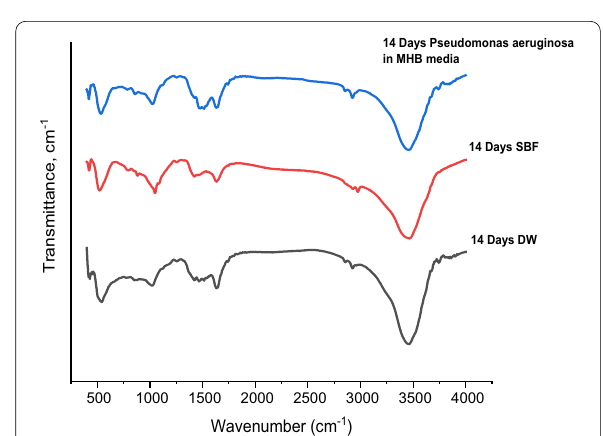
Fig. 10 FTIR spectral bands of 14-day sample cured in distilled water (DW) simulated body fluid (SBF) and Pseudomonas aeruginosa in Mueller Hinton Broth (MHB